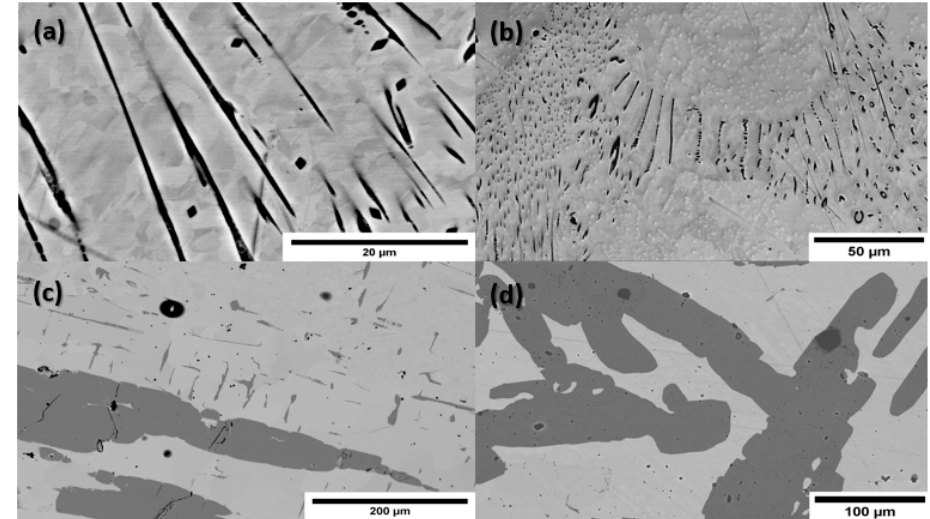
Figure 2. Representative backscatter electron images of four different MnBi-Bi composite samples: ( a ) 1 at.%; ( b ) 2 at.%; ( c ) 20 at.% magnetically annealed; ( d ) 20 at.% unannealed. The darker features correspond with MnBi grains and the brighter areas are the Bi matrix. Needle-like structures can be seen in the low Mn content samples, while elongated polycrystals of MnBi are observed in the 20 at.% samples. The random orientation of the MnBi grains in the unannealed sample is evident in the rounded edges and inconsistent elongation direction of the grains.